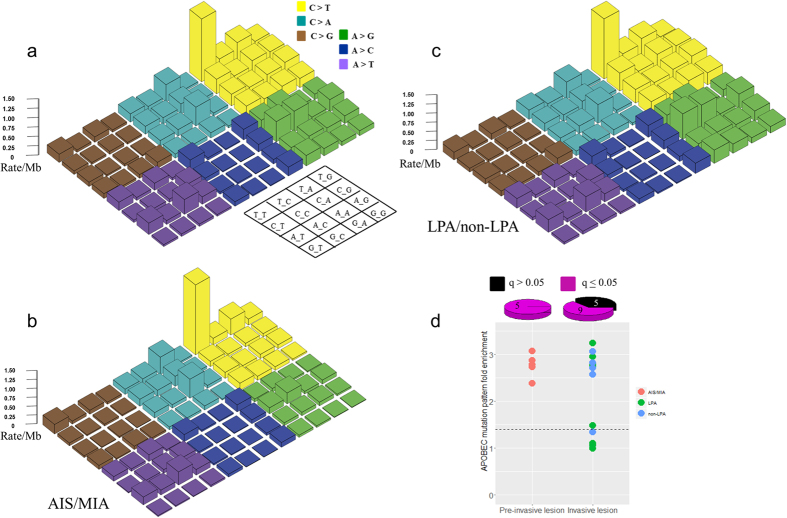
Lego plot of average mutation frequency across 19 lung adenocarcinoma specimens with prior diagnosed bronchiolo-alveolar carcinoma (a) revealed significant cluster mutation pattern of C > T, especially TCW motif. Average mutation frequency according to AIS/MIA (b) and LPA/non-LPA (c) showed a similar pattern therefore AIS/MIA had more predominant than LPA/non-LPA. APOBEC-mediated mutagenesis fold enrichment according to individual lesion was determined. P-values for significance of the APOBEC mutation pattern were corrected using the Benjamini-Hochberg method. Samples with q-value more than 0.05 were considered non-significant (d). All AIS/MIA and the majority of LPA/non-LPA cases had a significant APOBEC-mediated mutagenesis pattern. The dashed line divides the samples with q-values more than 0.5 (below the line) and samples with q-value < 0.05 (above the line).